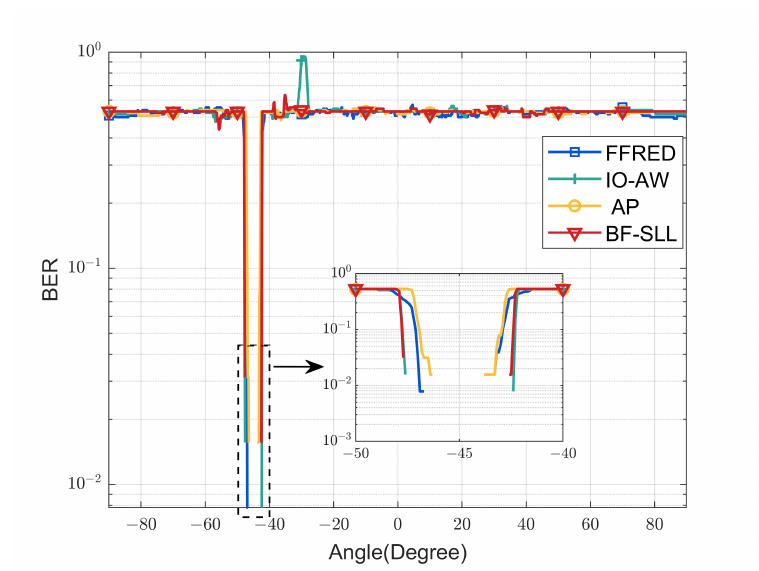
Figure 7. Bit error rate (BER) versus spatial angle of different methods.